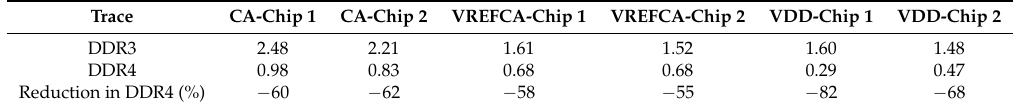
Table 5. Comparison of maximum induced voltages for most sensitive traces of DDR3 and DDR4 nets across all SODIMM chip positions (see waveforms in Figure